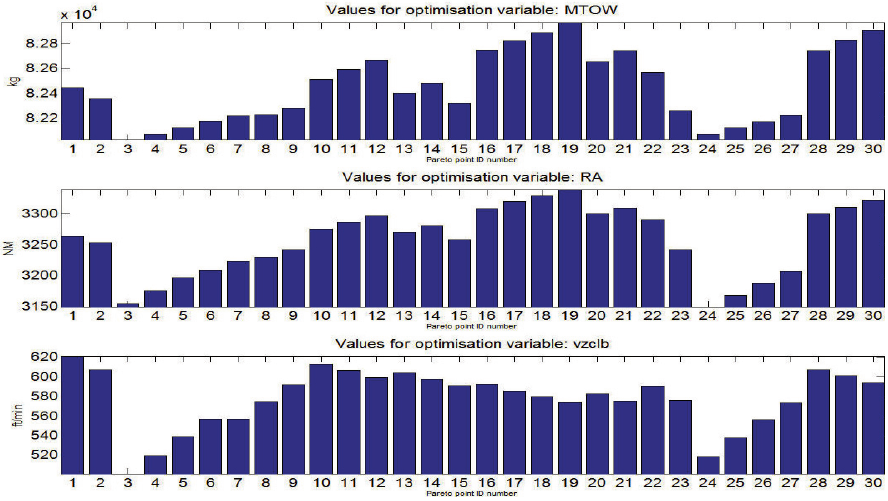
Fig. 12. Pareto frontier – absolute values by